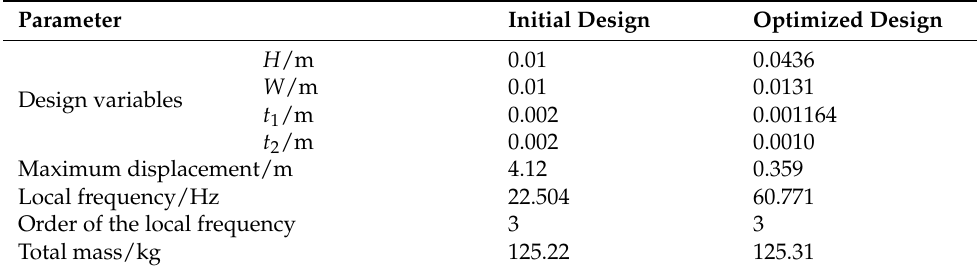
Table 3. Optimization results for the thin plate